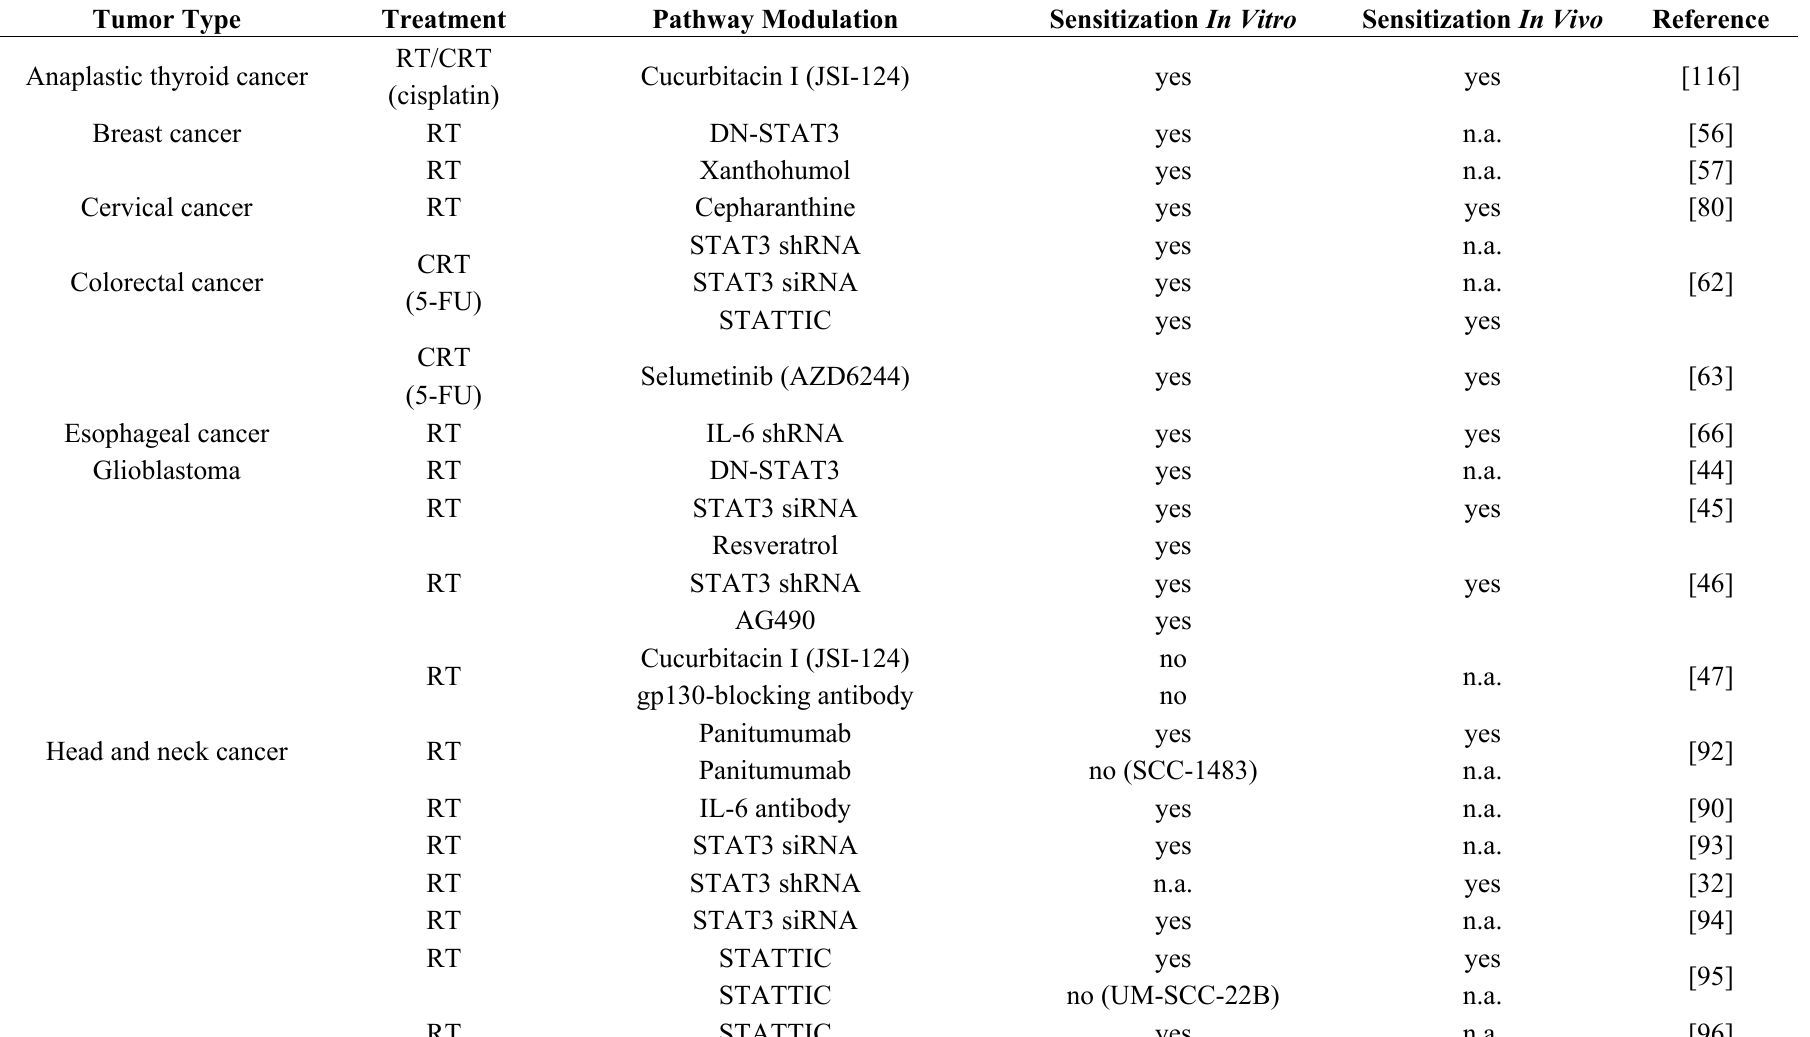
Table 1. Reports on RT- or CRT-sensitization by STAT3 pathway